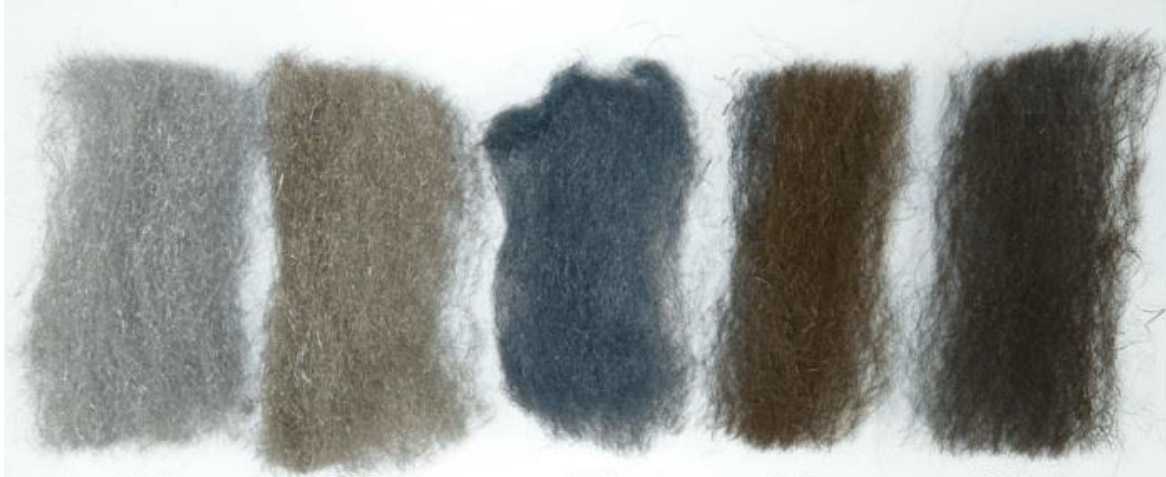
Figure 2. Wool samples after thermal treatment under an inert atmosphere. From left to right: Initial sample, sample treated at 200 °C, sample treated at 300 °C, sample treated at 400 °C, and sample treated at 500 °C.